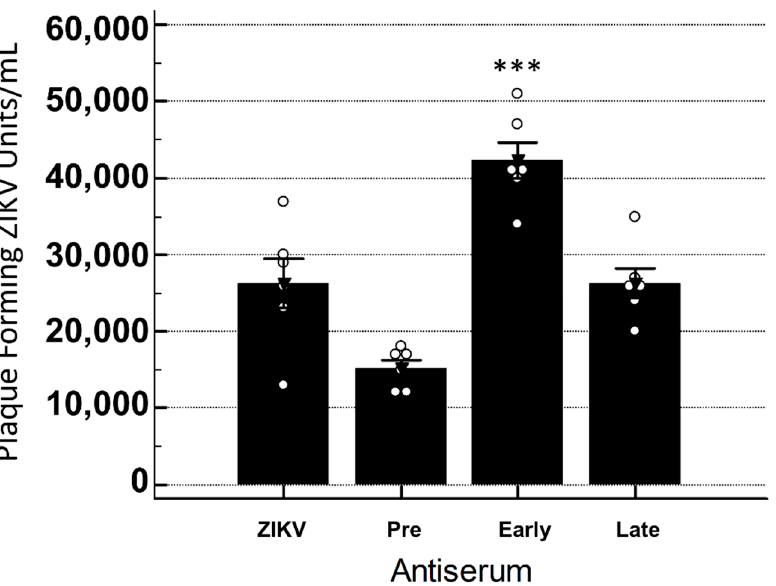
Figure 5. Viral titration of EBs after direct infection with ZIKV or ZIKV + Antisera. Bars signify average plaque-forming units per mL ± standard error of 3 independent trials with 3 replicates each. Dots represent individual data points for the treatment. ANOVA with a Tukey–Kramer post-hoc test for pairwise comparisons and a Shapiro–Wilk test for normality of distribution were performed. Significant increases in ZIKV titers were seen in EBs when Early antiserum was present as compared to ZIKV only ( p < 0.001). Statistical significance is denoted by ***. All ◦ are individual data points within that group.